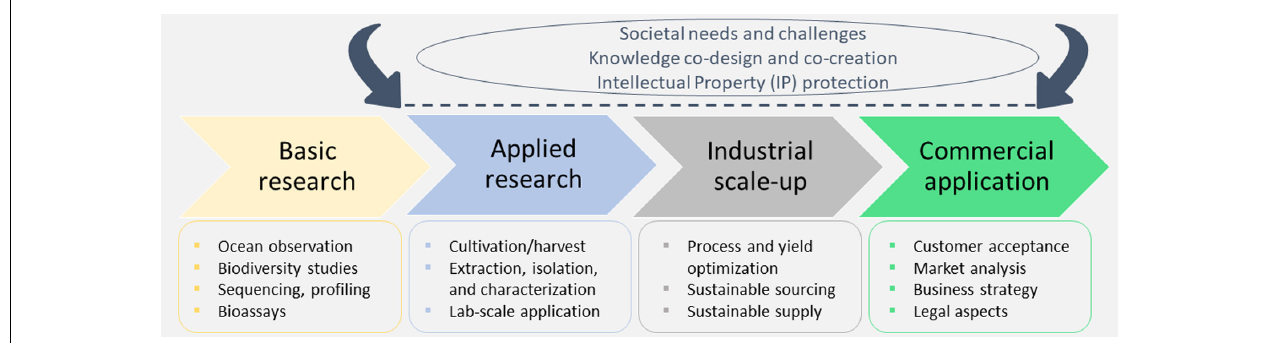
FIGURE 1 | A simplified representation of the marine biotechnology pipeline that is intrinsically interdisciplinary, combining basic and applied research with industry and business